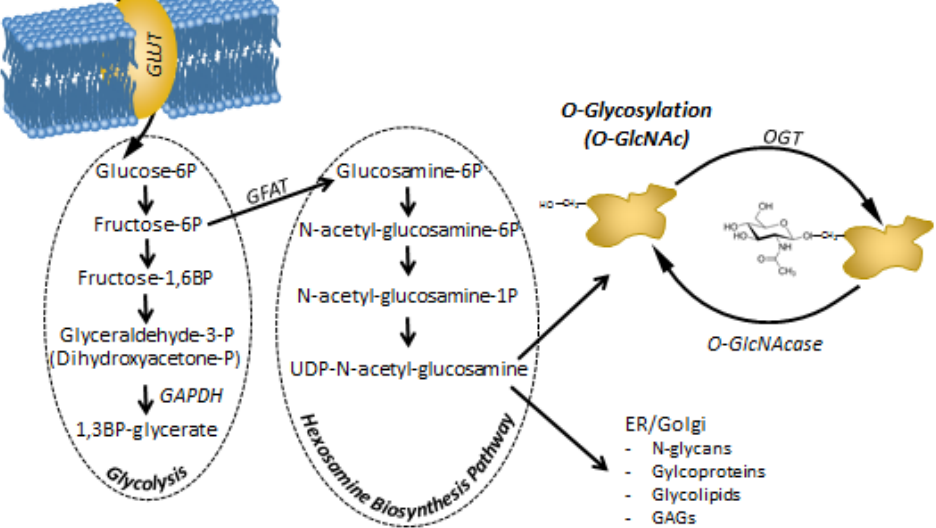
Figure 2. Metabolites of the hexosamine biosynthesis pathway (HBP) and protein O-Glycosylation (O-GlcNAc) modification. HBP branches off from glycolysis at fructose-6P. Thus, the amount of the end-product of HBP; UDP-N-acetyl-glucosamine (UDP-GlcNAc) depends on the rate of glucose entering the cells, but also on the rate of glycolysis that process the majority of fructose-6P. Increased glucose uptake or a block in glycolysis (e.g. inhibition of GAPDH by ROS) will increase the flux through HBP. It has to be noted that lipid (acetylation), protein (transfer of the amino group from glutamine) and nucleotide (linkage of N-acetyl-glucosamine to UDP) homeostasis may also influence HBP apart from carbohydrate metabolism [189]. UDP-GlcNAc is a substrate for many complex biomolecules and post-translational modifications. In particular, protein O-GlcNAc. As O-GlcNAc is recognized to modify and influence hundreds if not thousands of proteins, piling evidence suggests that it may be a direct mediator and feed-back mechanism between metabolic challenges and cellular adaptation and regulatory functions, including cell proliferation.